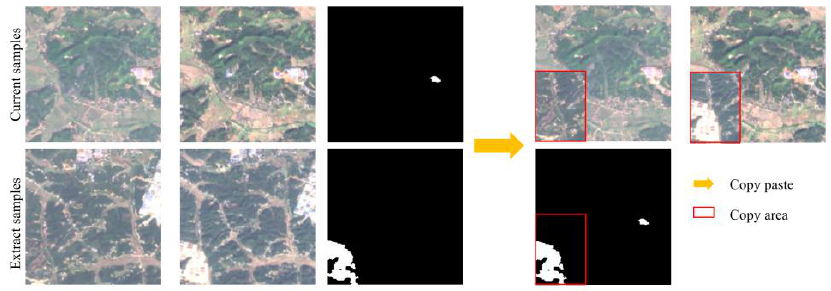
Figure 5. Copy-paste data augmentation. Copy-paste data augmentation also enriches the diversity of sample